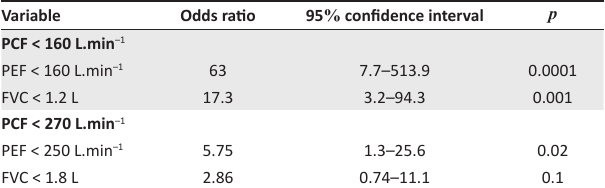
FIG URE 5: Bland–Altman plot comparing the difference between peak cough flow (PCF) and peak expiratory flow (PEF) (PCF–PEF) and mean (PCF–PEF). The upper and lower limits of agreement are set at mean difference (PCF–PEF) ± 1.96 ´ standard deviation of the differences. The central horizontal line indicates the mean difference (14.0 L.min –1